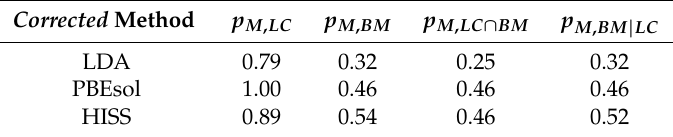
Probability that a given method gives “good” results for lattice constants p M , LC , for bulk moduli p M , BM , and for both of them p M , LC ∩ BM . The uncertainty on all reported values, estimated by the Agresti–Coull formula [22], is about 0.1 for a data set of size 28. Results are obtained using corrected